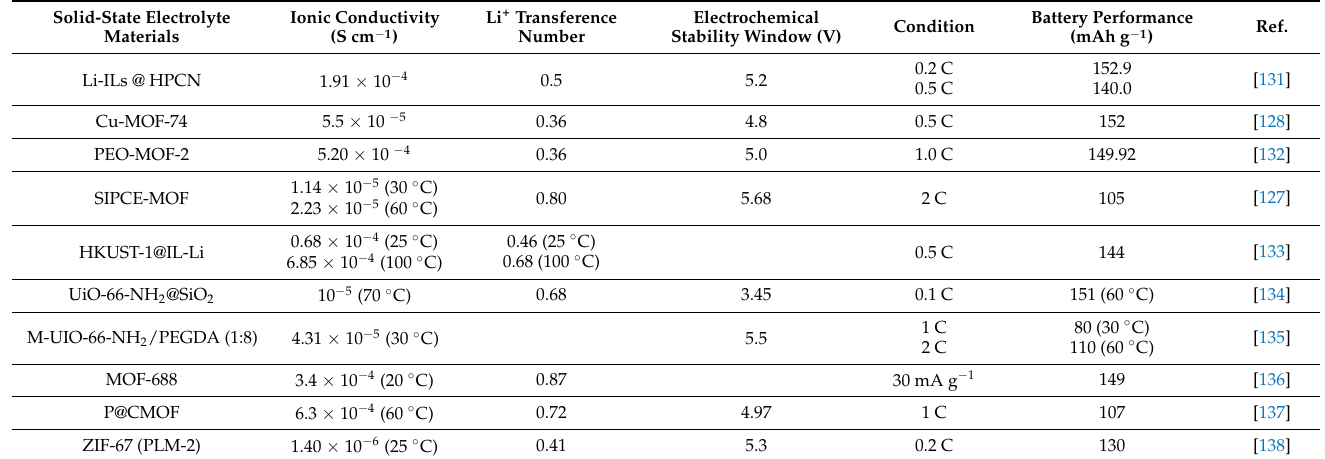
Table 2. Summary of the major performances of MOF-based SSEs.